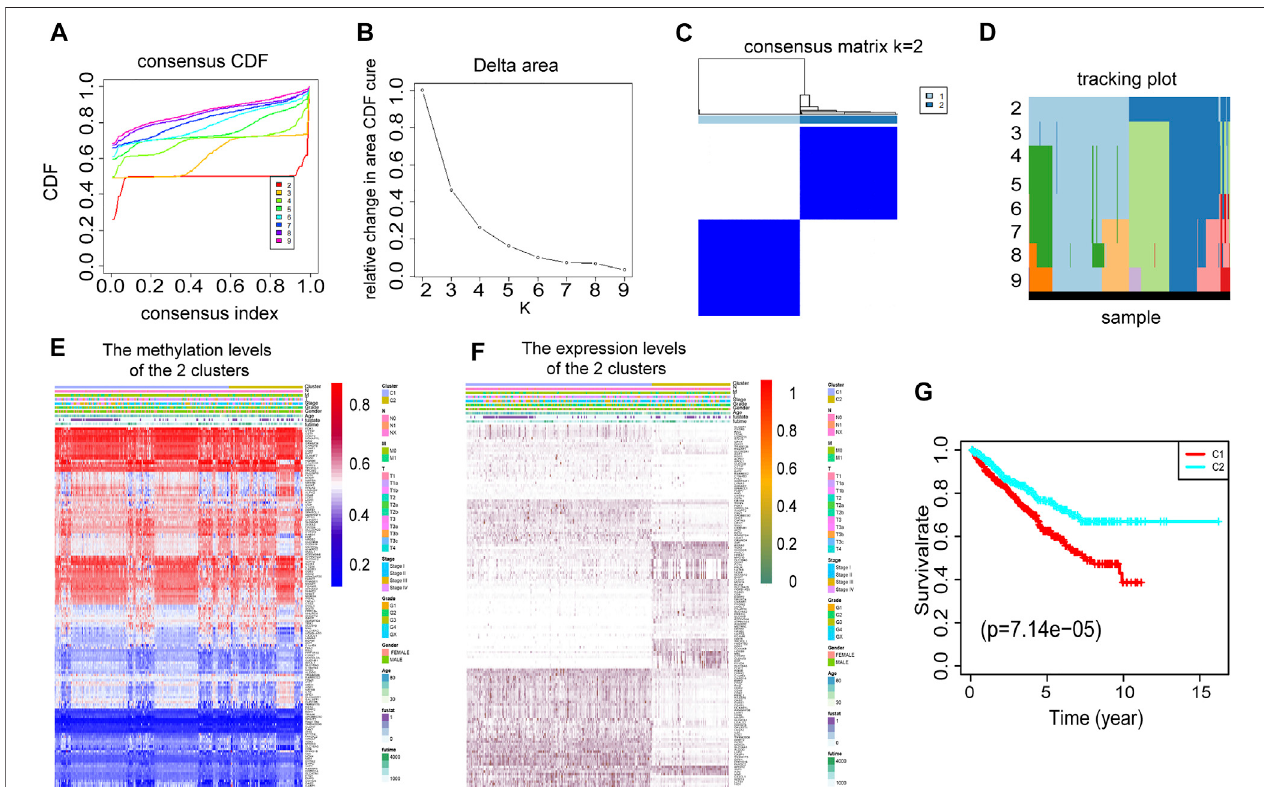
FIGURE3| Consensusclusteringbasedon146DEMDGs. (A) CDFforRCC. (B) TheareaundertheCDFcurveinRCC. (C) ConsensusclusteringmatrixforRCCat k = 2. (D) Tracking plot for k from 2 to 9. (E) Heatmap of methylation levels of 146 DEMDGs in the two clusters, and the distribution of clinical features was compared in thetwoclusters. (F) Heatmapofgeneexpressionlevelsof146DEMDGsinthetwoclusters,andthedistributionofclinicalfeatureswascomparedinthetwoclusters. (G) The survival curves showed signi fi cant prognostic differences in the two clusters.